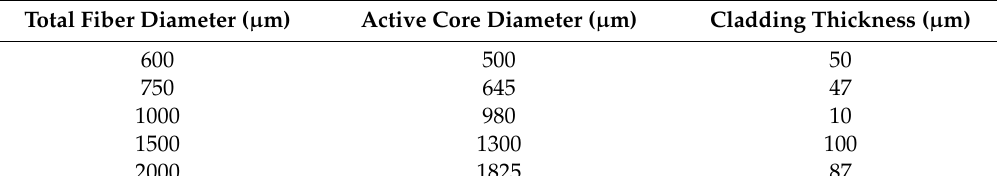
Table 1. Summary of the five fiber diameters.